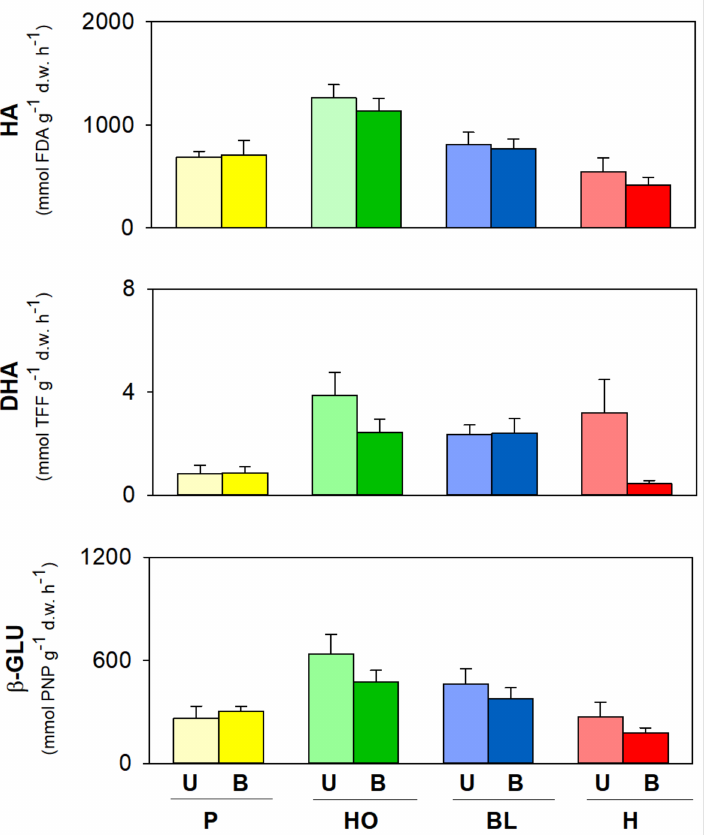
Figure 2. Mean values ( n = 12, ± s.e.) of the enzymatic activities (hydrolase: HA; dehydrogenase: DHA; β -glucosidase: β -GLU) measured in surface (0–10 cm) soils collected inside the Vesuvius National Park (Southern Italy) in unburnt (UB) and burnt (B) soils under different vegetation covers (P: pine; HO: holm oak; BL: black locust; H: